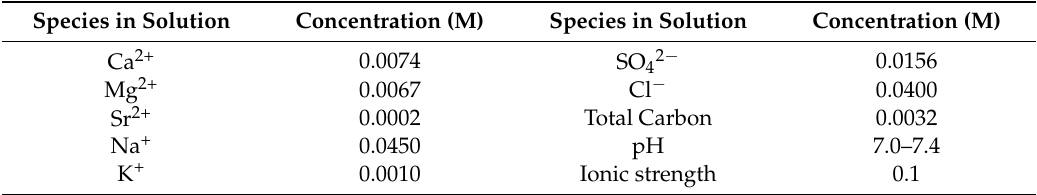
Table 2. Composition of the reconstituted COx solution at 25 ◦